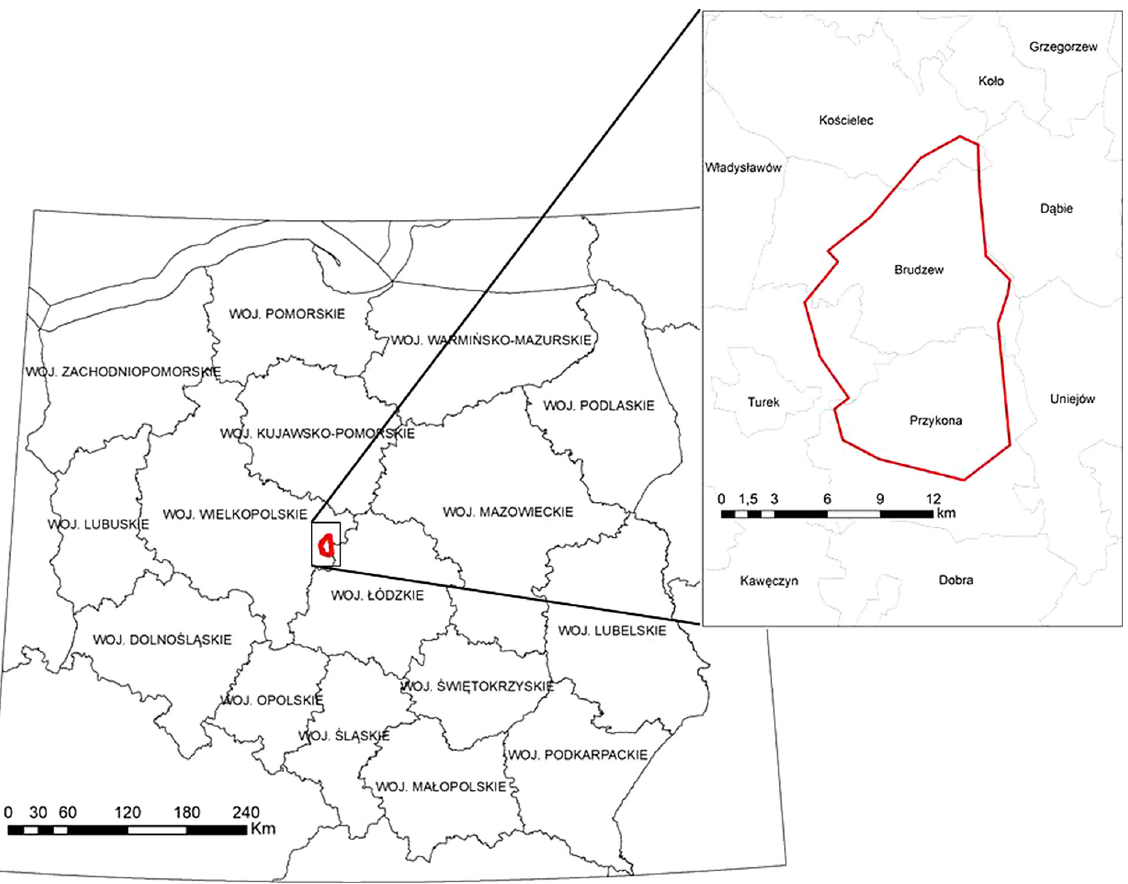
Fig. 1. Study area. Source: own